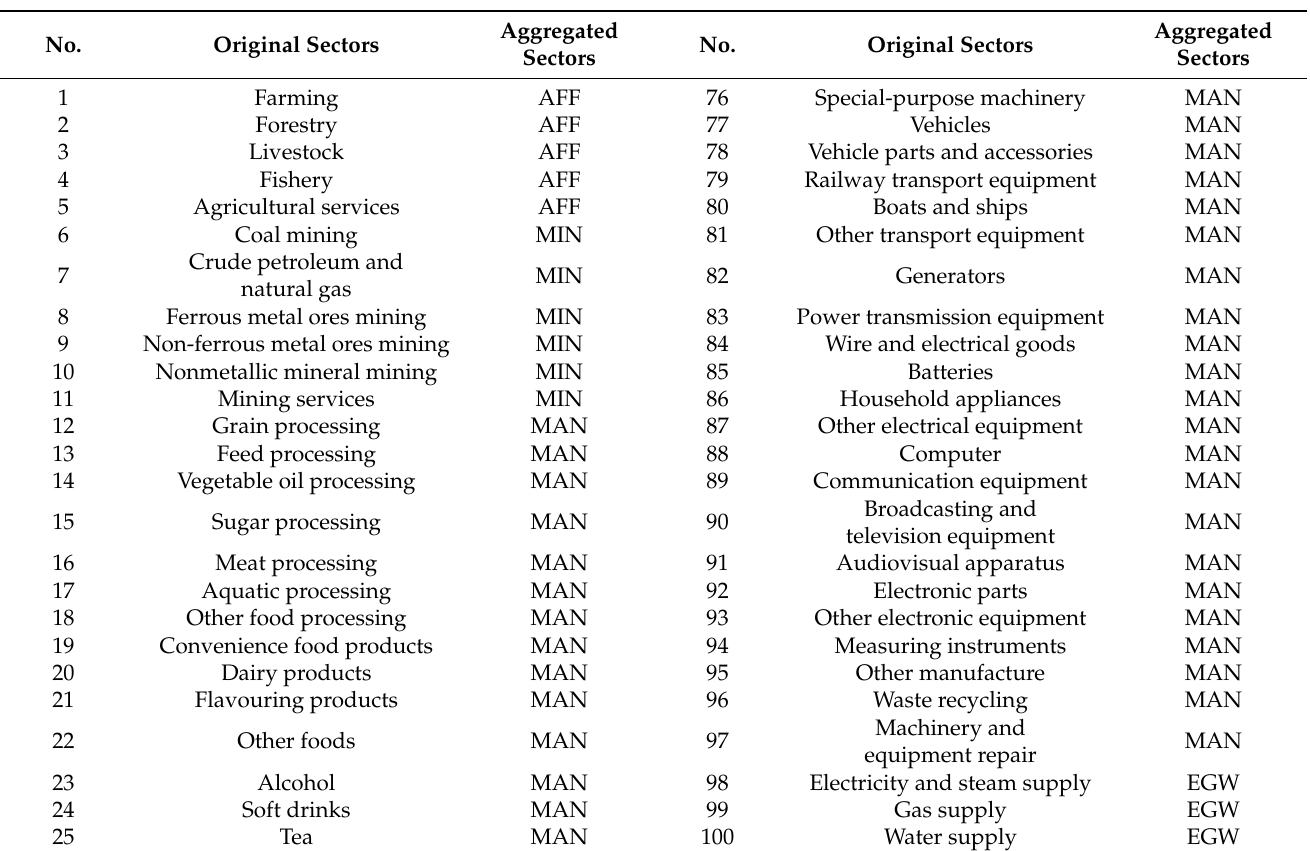
Table A2. The sectorial concordance between the aggregated sectors and the original sectors in the input–output table of